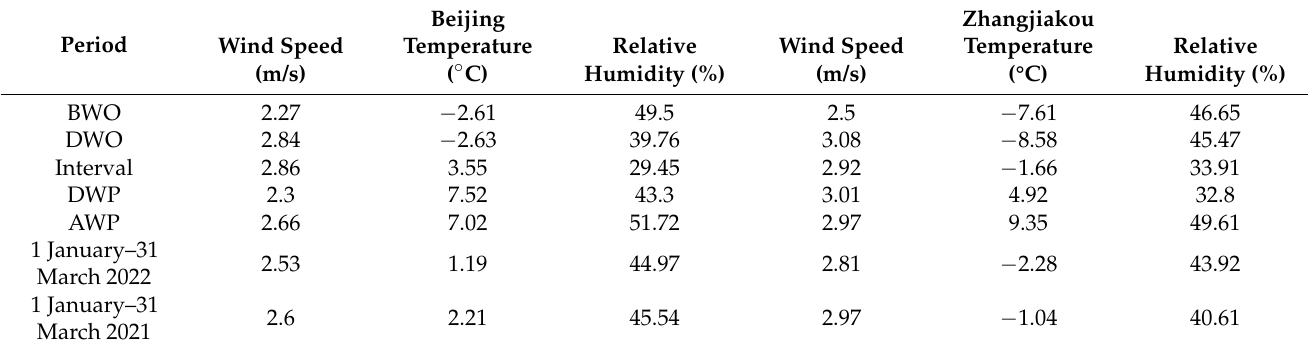
Table 2. Meteorological data for Beijing and Zhangjiakou during each period.